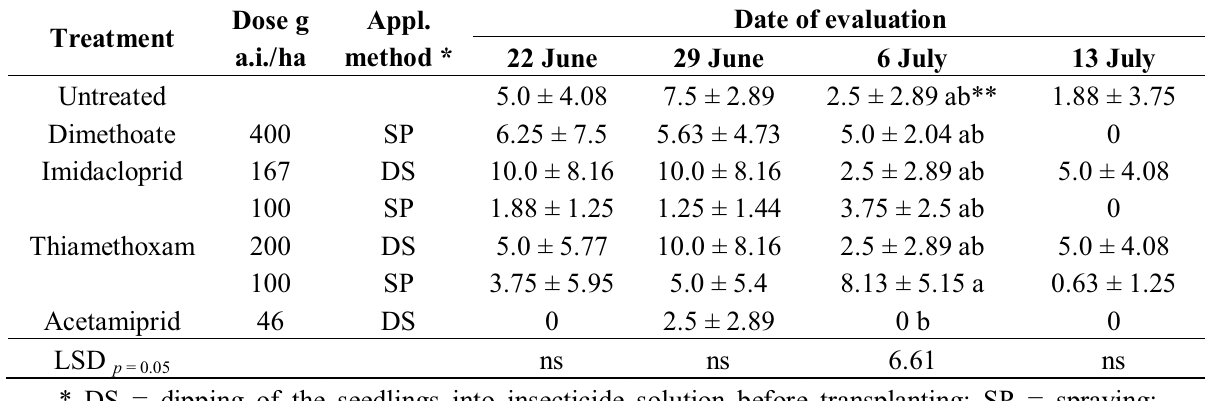
Table 5. Percentage (±SEM) of cabbage plants showing symptoms of Delia radicum (L.) larval infestation (wilting) in 2007 following treatment with various insecticides, or